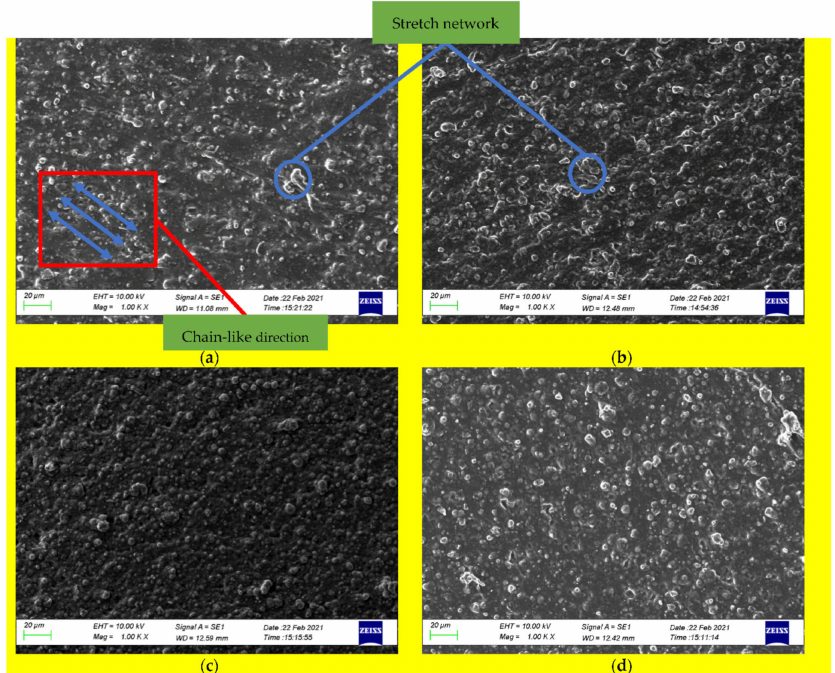
Figure 2. SEM results of cross-sectional MRE sample slices; ( a ) anisotropic untreated; ( b ) anisotropic treated; ( c ) isotropic untreated; ( d ) isotropic